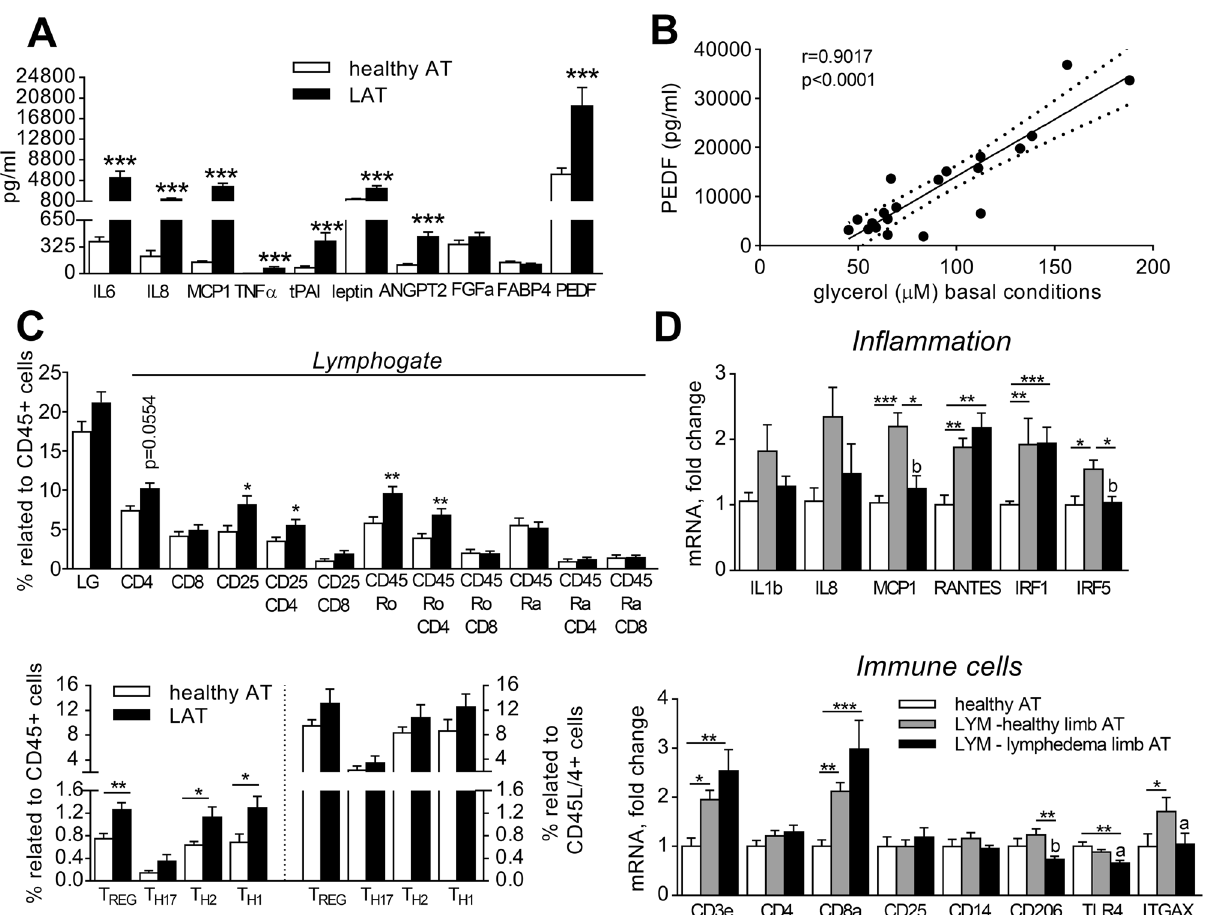
Figure 3. Immune parameters of LAT. ( A ) Cytokines secretion from AT explants (unpaired T- test of LN transformed data, ***p < 0.001). ( B ) Correlation of PEDF and glycerol release from AT explants (Pearson correlation coefficient). ( C ) Relative content of immune cell populations in AT, expressed as percentage of CD45+ positive cells or CD45/CD4+ positive cells within lymphogate (Mann Whitney test, *p < 0.05, **p < 0.01). ( D ) mRNA levels of immune markers in whole AT expressed as fold change over the mean expression of healthy group (Kruskal–Wallis test of 2 ΔCt values, Dunn’s correction, comparison of 3 groups, *p < 0.05, **p < 0.01, ***p < 0.001; Wilcoxon test of paired healthy and diseased limb of LYM subjects, a- p < 0.05, b- p <